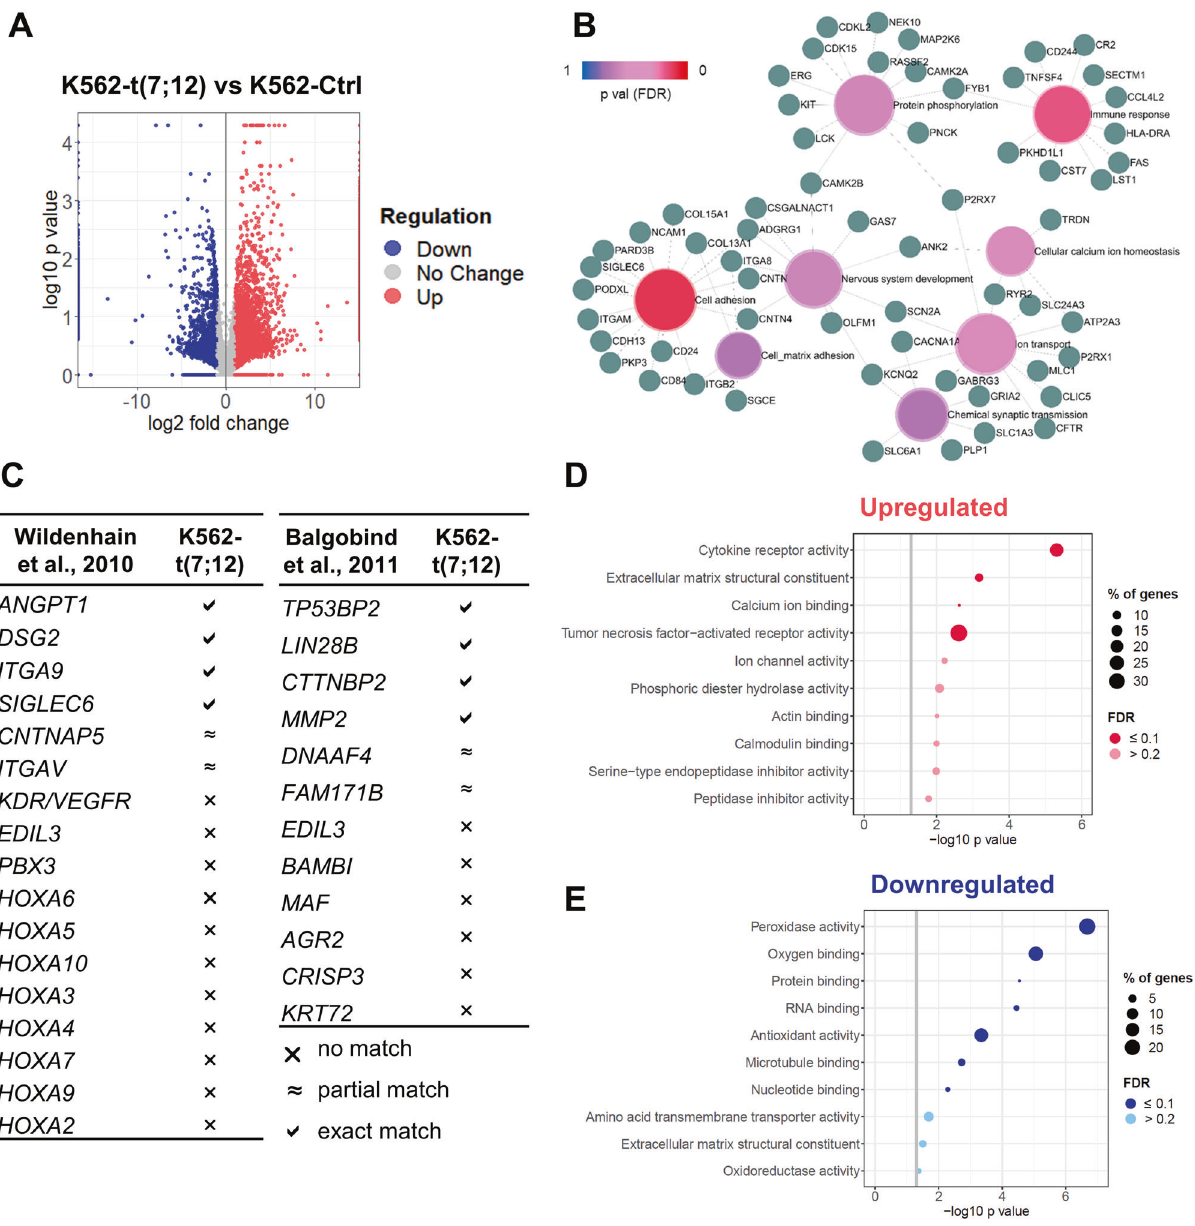
Fig. 3 Transcriptional analysis of K562-t(7;12). A Volcano plot showing differentially expressed genes by RNA sequencing of K562-t(7;12) compared to K562-Ctrl (three subclones per condition), depicting up- (in red) and downregulated (in blue) genes and their statistical signi fi cance by − log10 p value. Genes with an absolute log2 fold change lower than 1 are shown in grey ( ‘ No change ’ ). B Gene Ontology (GO) network plot of differentially expressed genes by false discovery rate (FDR) < 0.1 showing signi fi cant biological processes (PANTHER) and genes associated to each GO term, constructed on ExpressAnalyst (available at www.expressanalyst.ca). C Comparison of differentially expressed genes in K562-t(7;12) and published reports of genes associated with t(7;12) patients. Symbols indicate difference in expression between K562-t(7;12) and K562 control by statistical signi fi cance (threshold p ≤ 0.05), de fi ned as an exact gene match, a partial match (i.e. dysregulation of a gene belonging to the same family), or no match. GO terms relating to molecular functions (PANTHER) of upregulated ( D ) and downregulated ( E ) genes in K562-t(7;12). The grey intercept marks the p = 0.05 threshold in – log10. The size of the dots indicate the percentage of genes mapping to a speci fi c term. Dark red or blue indicates an enrichment with an FDR ≤